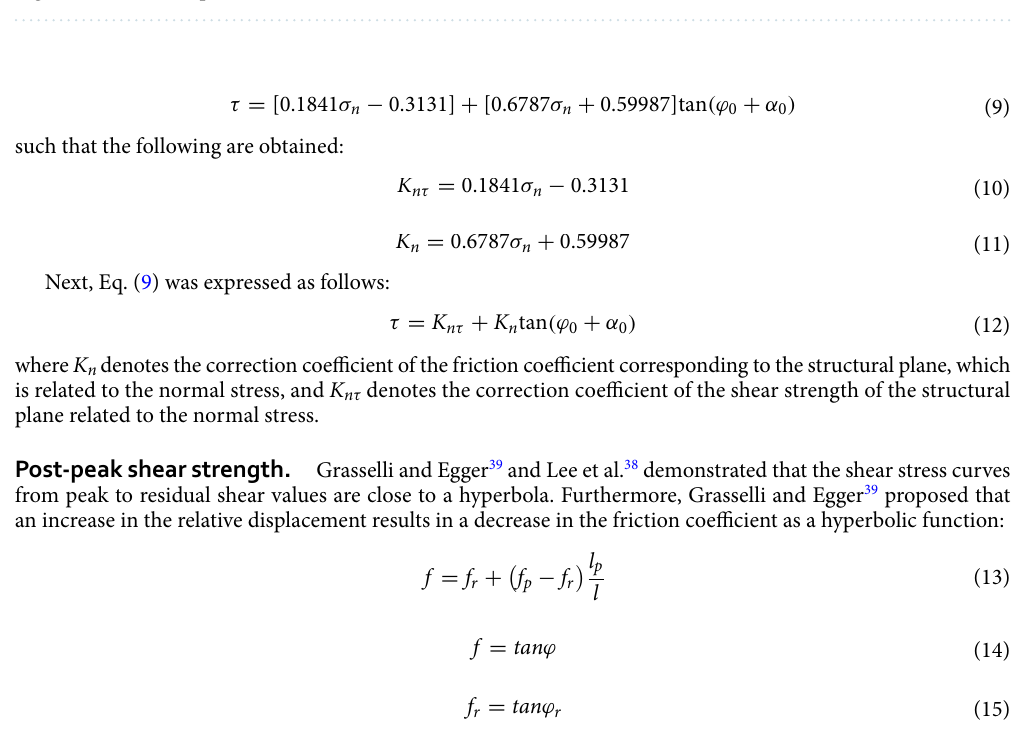
Figure 9. Trends of parameters A and B as a function of tan (ϕ 0 + α 0 )